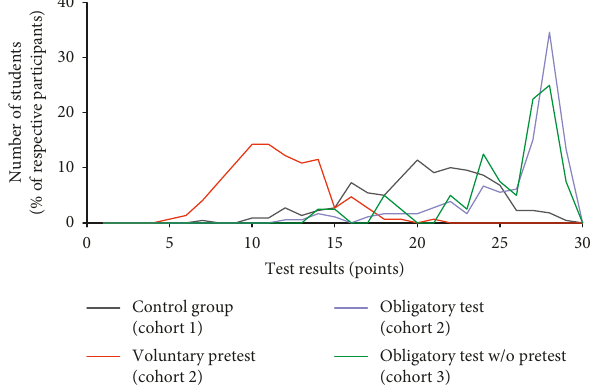
Figure 7: Summary of distributions of points of cohort 1 (control group, n � 219), cohort 2 (pretest group) in the voluntary exam ( n � 147) and in the obligatory exam ( n � 142), and cohort 3 (obligatory exam only group, n � 37) presented as percent of the respective participating number of